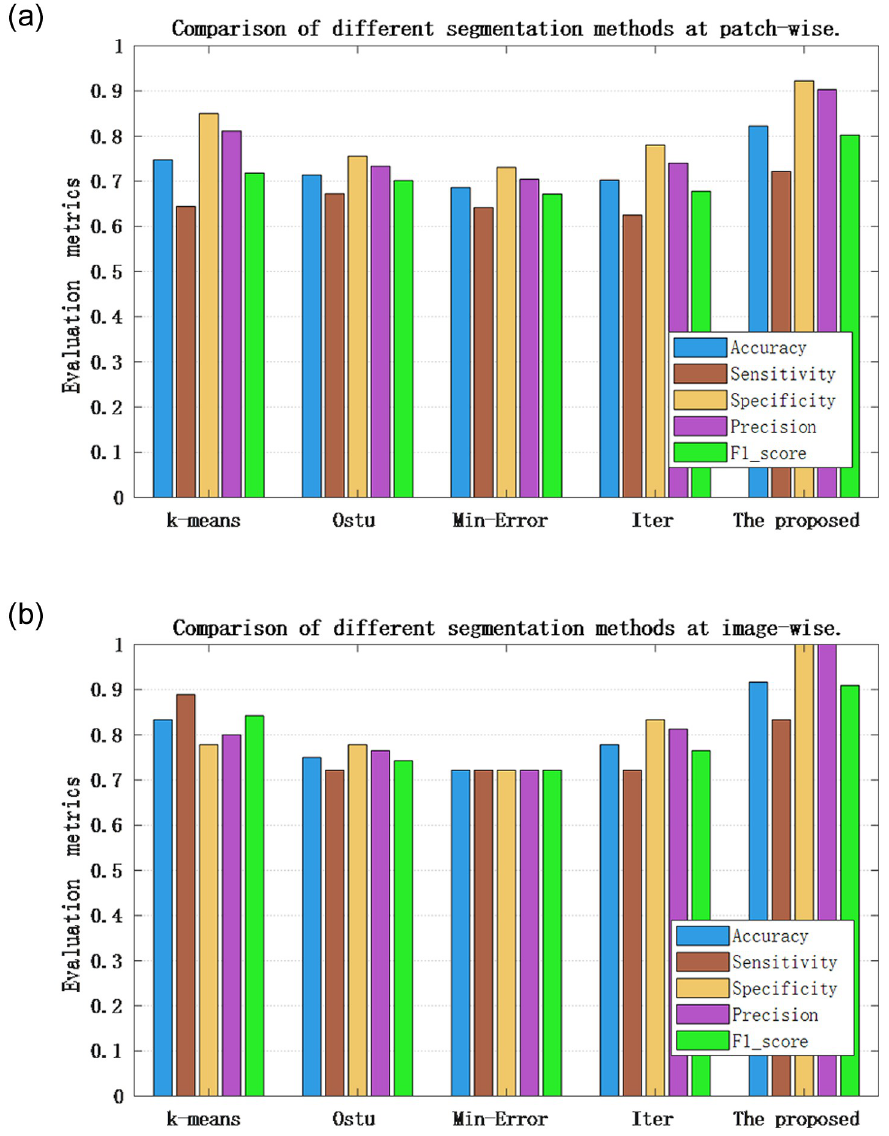
Fig 9. Comparison of the classification performance at the patch-wise and the image-wise on fused features. (a) Comparison of different segmentation methods at patch-wise, (b) Comparison of different segmentation methods at